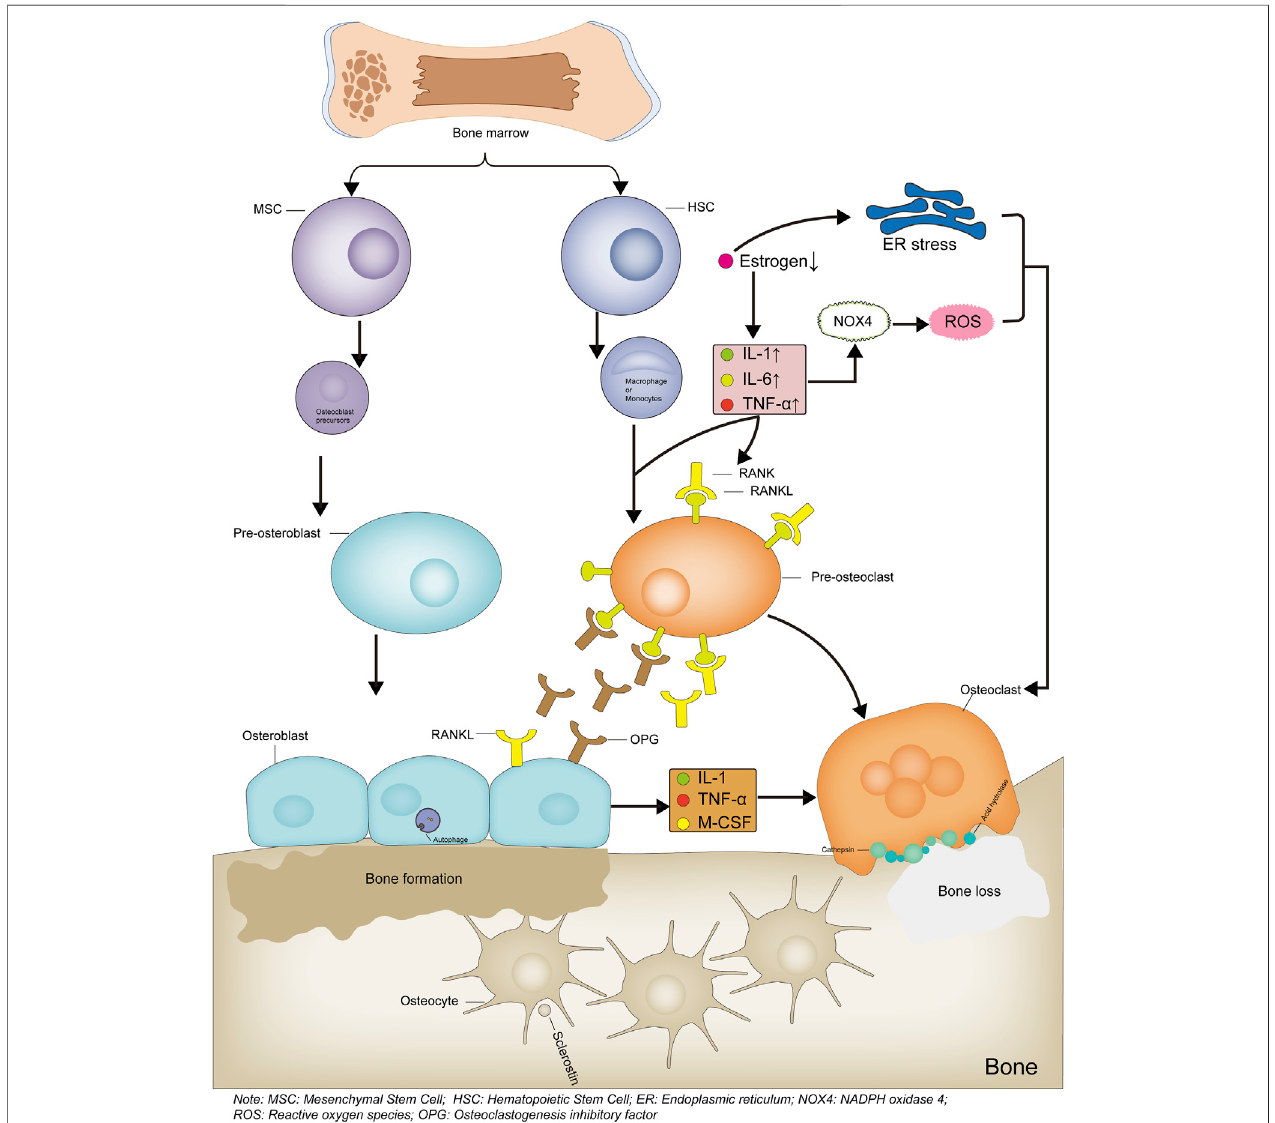
FIGURE 1 | Mechanism diagram of bone formation and loss. Bone marrow-derived hematopoietic stem cells differentiate into monocytes or macrophages, which thendifferentiateintoosteoclastprecursorcells,thendifferentiateintoosteoclastsandparticipateinboneloss.Whenestrogenlevelsarereducedorin fl ammatoryfactors areactivated,theRANKL/RANKsignalingpathwayisactivated,leadingtoincreasedosteoclastdifferentiation.TheincreasedROSlevelsorendoplasmicreticulumstress also leads to increased osteoclast differentiation. Bone marrow-derived mesenchymal stem cells differentiate into osteoblast precursor cells, which then differentiate into osteoblasts and participate in bone formation. The Osteoblasts produce OPG, competitively bind RANKL and inhibit osteoclast differentiation, thereby reducingosteoclastproduction.Boneformationandbonelossareindynamicbalancetomaintainboneintegrityandnormalbonestructureandfunction.Boneformation and bone loss are in dynamic balance to maintain skeletal integrity, normal bone structure and function.